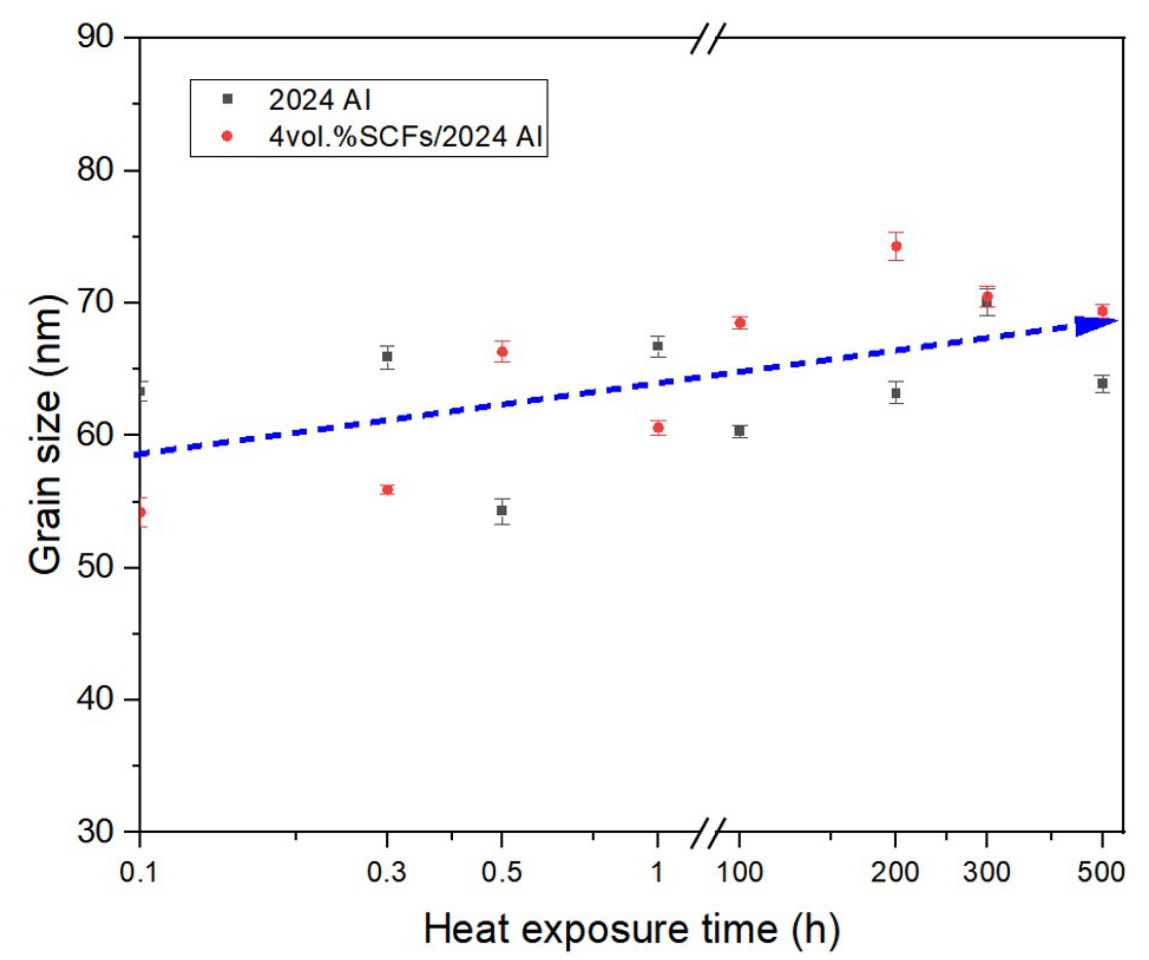
Figure 5. The change of aluminum grain size for both 2024 Al and SCFs/2024 Al with the change of thermal exposure time. (Samples without thermal exposure are defined as 0.1 h).